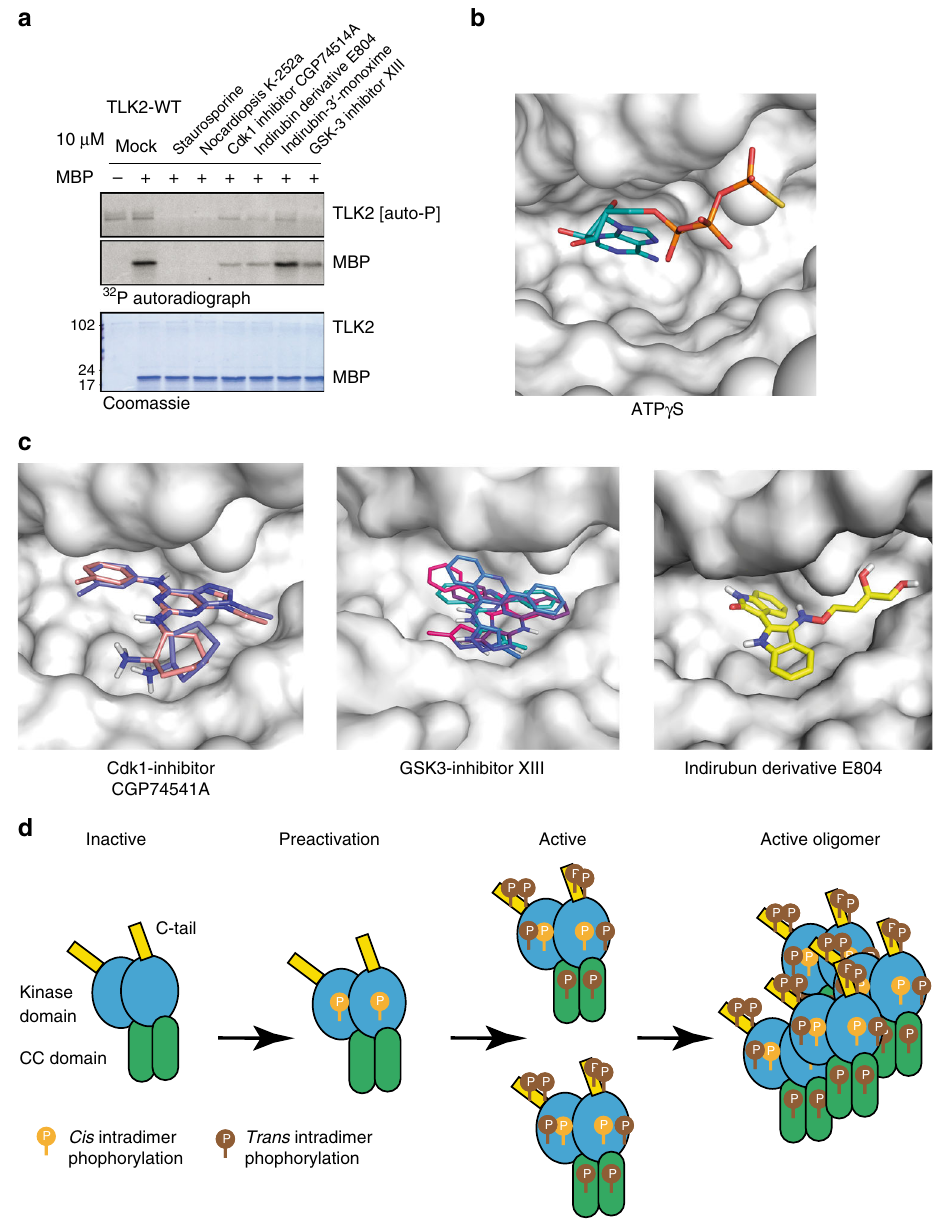
Fig. 6 TLK2 inhibition and activation model. a In vitro kinase assay of TLK2 isolated from AD293 cells by Streptavidin pull-downs in the presence or absence of the substrate MBP and the indicated kinase inhibitors. All inhibitors were used at 10 µ M and the Coomassie stained gel shows equal loading of TLK2 and MBP. b Detailed view of the ATP-binding pocket in the TLK2 kinase structure showing the bound ATP γ S molecule. c Zoom of the ATP-binding pocket containing the modelled molecules shown to inhibit TLK2 kinase activity. The best score modelling results displayed no steric clashes. d Model of TLK2